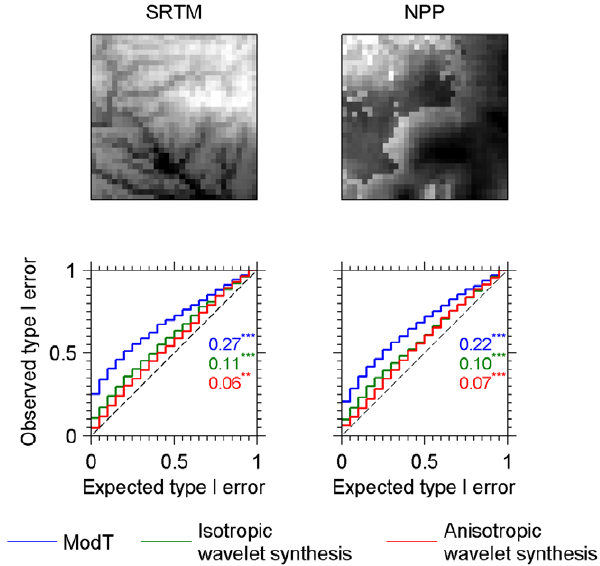
Figure 3. Type I error calibration curves for real data pertaining to earth relief or biomass production. Observed versus expected type I error probabilities resulting from an independence tests on 1000 pairs of simulated images, are plotted for every combination of method (colour curves) and dataset (panels). Methods compared are the corrected t -test of Dutilleul (ModT) and wavelet-based image synthesis method, with direction selectivity feature disabled (isotropic) and enabled (anisotropic). Data are non-overlapping windows extracted figure features particular extracts exemplifying the kind of patterns characteristic of each dataset. Each bin is 0.05 wide. The Kolmogorov- Smirnov (K.-S.) maximum difference statistic which measures the departure from the line of identity (dashed line) is indicated for each curve along with results of the derived test of the departure: ***= p - value , 0.001; **=0.001 # p -value ,